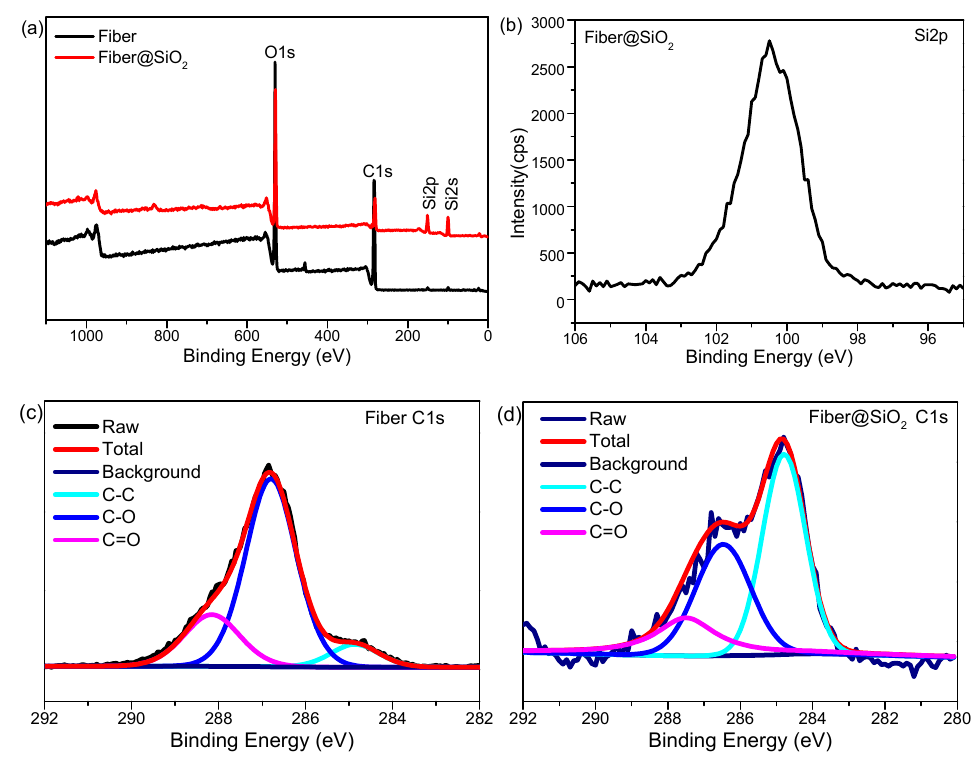
Figure 3. XPS spectra ( a ) and high resolution XPS spectra of Si 2p ( b ), C 1s ( c , d ) of raw cellulose fiber and SiO 2 modified cellulose fiber.